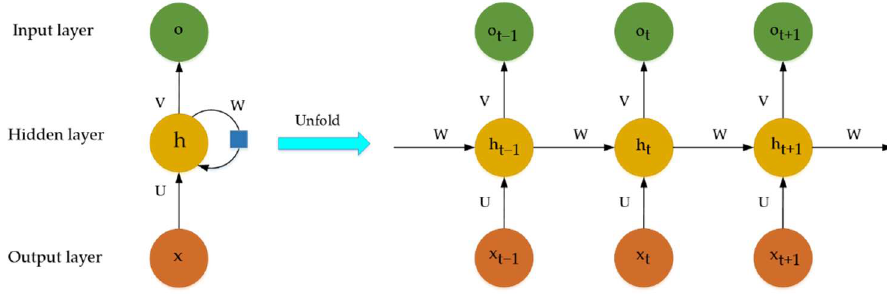
Figure 3. A schematic diagram of RNN unfolding in chronological order.